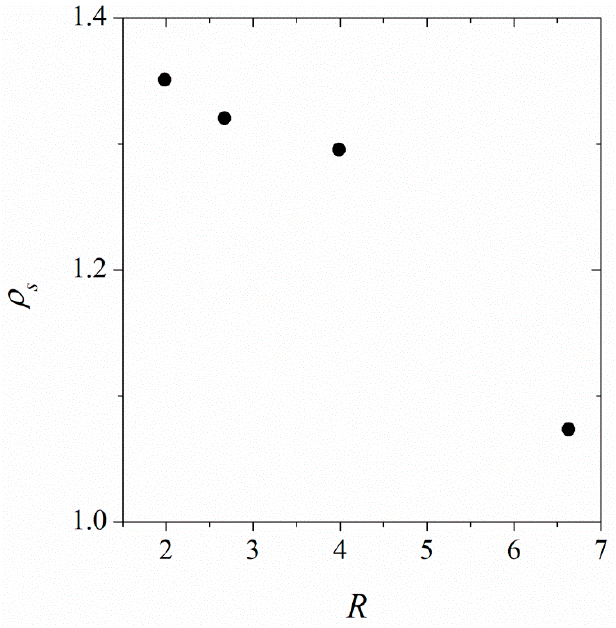
Figure 5. The surface density of DPPC at saturation, ρ s , as a function of CNT diameter, R